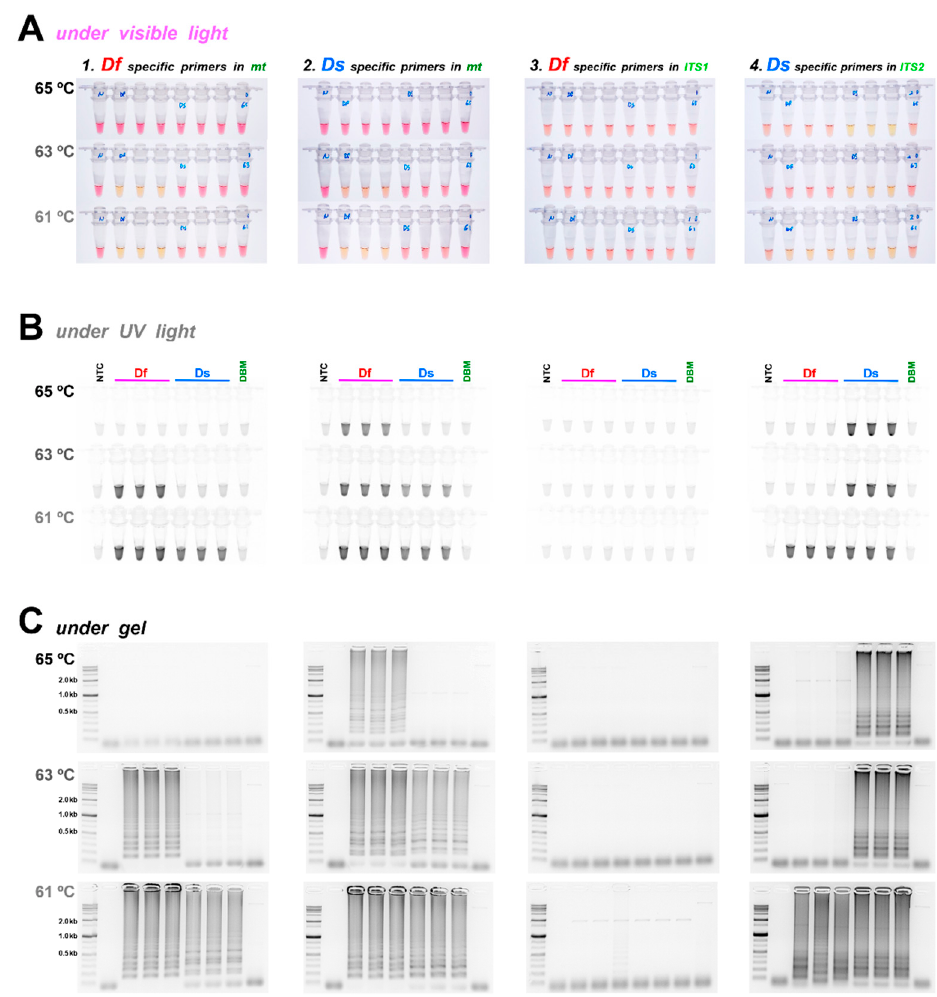
Figure 3. The sensitivity of the LAMP assay, using specific primers for mt genome, ITS1, and ITS2 regions under three temperature conditions (65, 63, and 61 °C) for 40 min for Df and Ds detected under ( A ) visible light, ( B ) ultraviolet light with SYBR Green, and ( C ) gel electrophoresis. The original pink color of the reaction mixture turned yellow in a positive reaction when the product was formed but remained pink in negative reactions. ITS, internal transcribed spacer; mt, mitochondrial; NTC, no template control; Df, Diadegma fenestrale ; Ds, Diadegma semiclausum ; DBM, diamondback moth; LAMP, loop-mediated isothermal amplification.